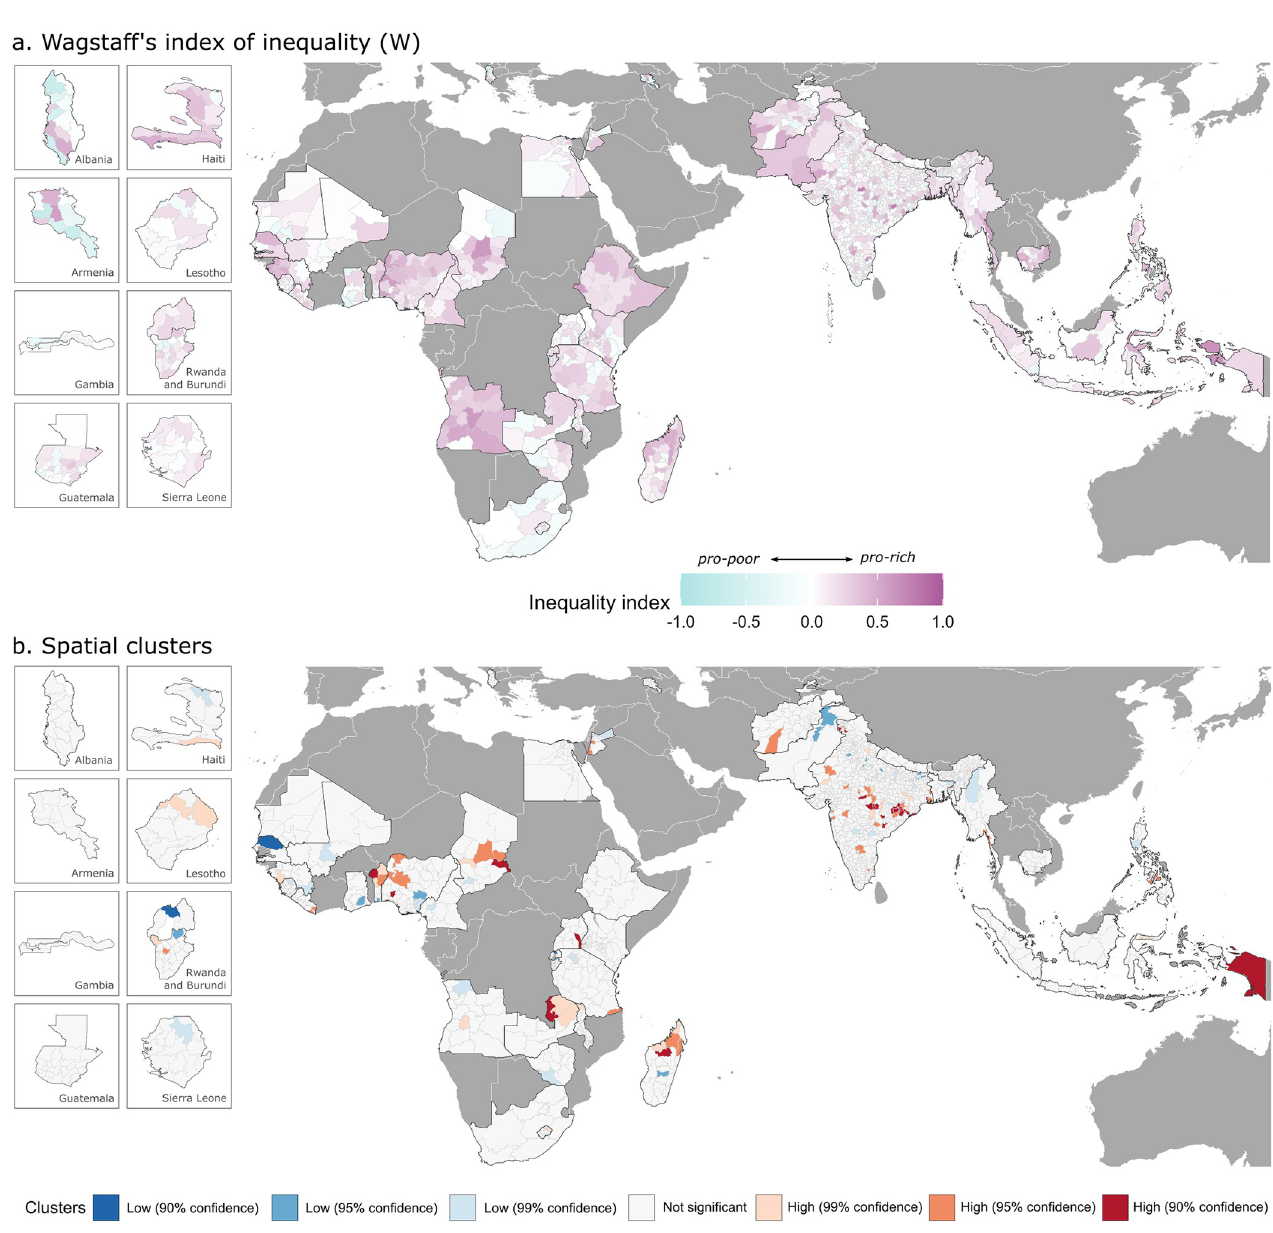
Fig 2. Subnational estimates of Wagstaff’s index (W) of socioeconomic inequality (a) and spatial clusters of administrative regions with high (red colors) and low (blue colors) degrees of inequality (b). Spatial boundaries were retrieved from Natural Earth (https://www.naturalearthdata.com/) using the “rnaturalearth” package (https://github.com/ropenscilabs/rnaturalearth).